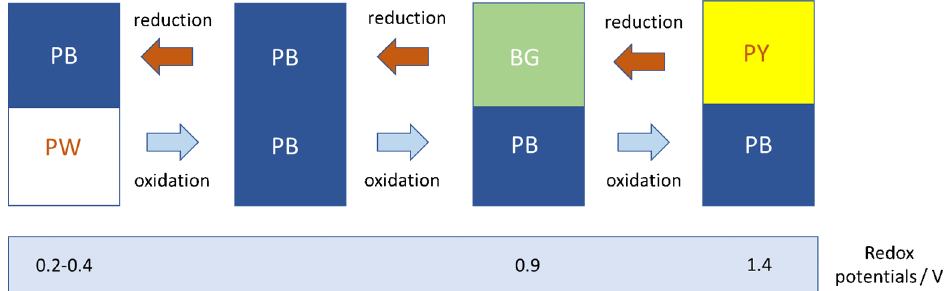
Figure 1. Different forms of Prussian blue depending on the state of oxidation. Each form possesses a characteristic redox potential, which affects the catalytic reaction mechanisms. Reproduced, after modification, with permission from [14].